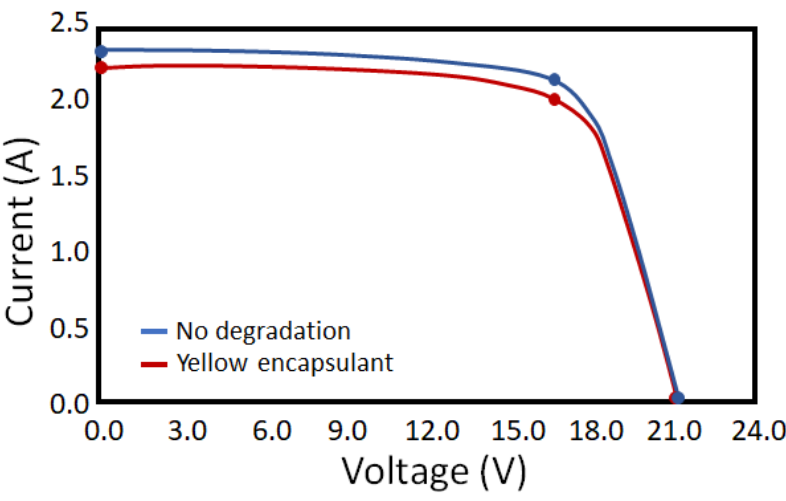
Figure 10. Encapsulant degradation effect on I-V curve